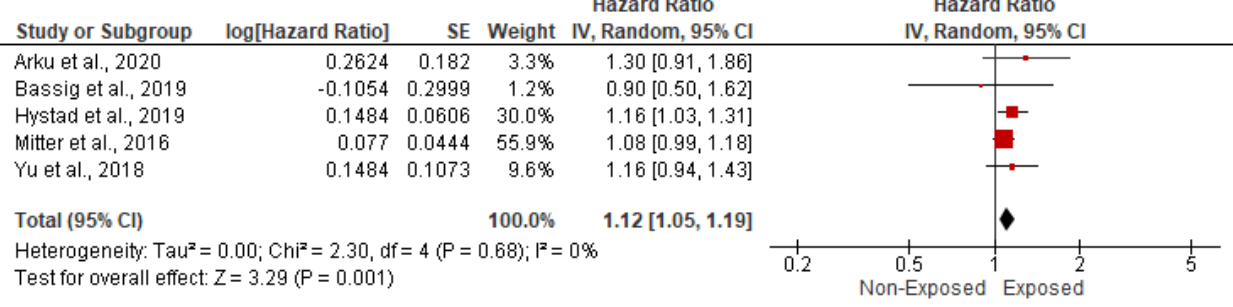
Figure 6. Forest plot of summary analysis of the hazard ratio and 95% CI of the association between HAP and stroke and cerebrovascular accidents. The size of the red squares is proportional to the statistical weight of each trial. The gray diamond represents the pooled point estimate. The positioning of both diamonds and squares (along with 95% CIs) beyond the vertical line (unit value) suggests a significant outcome (IV = inverse variance).